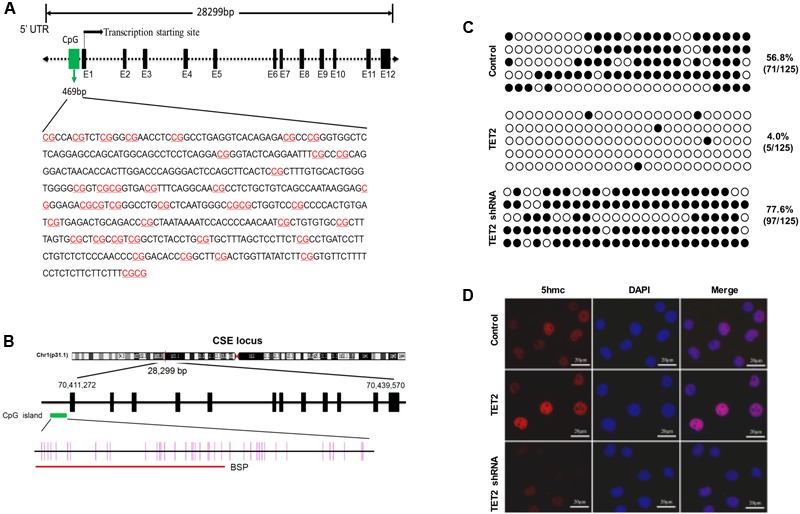
Effects of TET2 on the methylation level of the CSE promoter in oxLDL-treated HUVECs. (A) The features of CpG Island in human CSE gene promoter region was analyzed using the UCSC Human Genome Browser (http://genome.ucsc.edu/). (B) A schematic diagram of the CpG dinucleotides within the CSE promoter. The nucleotide number is relative to the transcription start site of CSE. The red line indicates the region that was tested with BSP. (C) HUVECs were transfected with or without TET2 overexpression plasmid or TET2 shRNA plasmid in the presence of oxLDL for 24 h. The methylation levels of the CSE promoters in each group of cells were determined by BSP method. Each row represents an individual clone sequenced; black and white circles represent methylated and unmethylated CpGs sites, respectively. The number of methylated CpGs divided by the whole CpG sites examined is given as a percentage of methylation. (D) Immunostaining for 5hmC in each group of cells. 5hmC is red, DAPI staining is blue, n = 4. Scale bar = 20 μm.